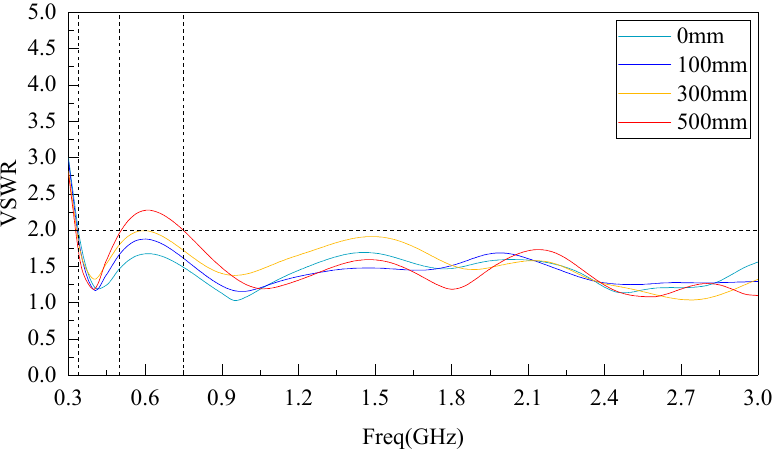
Figure 9. Simulation of VSWR curve.